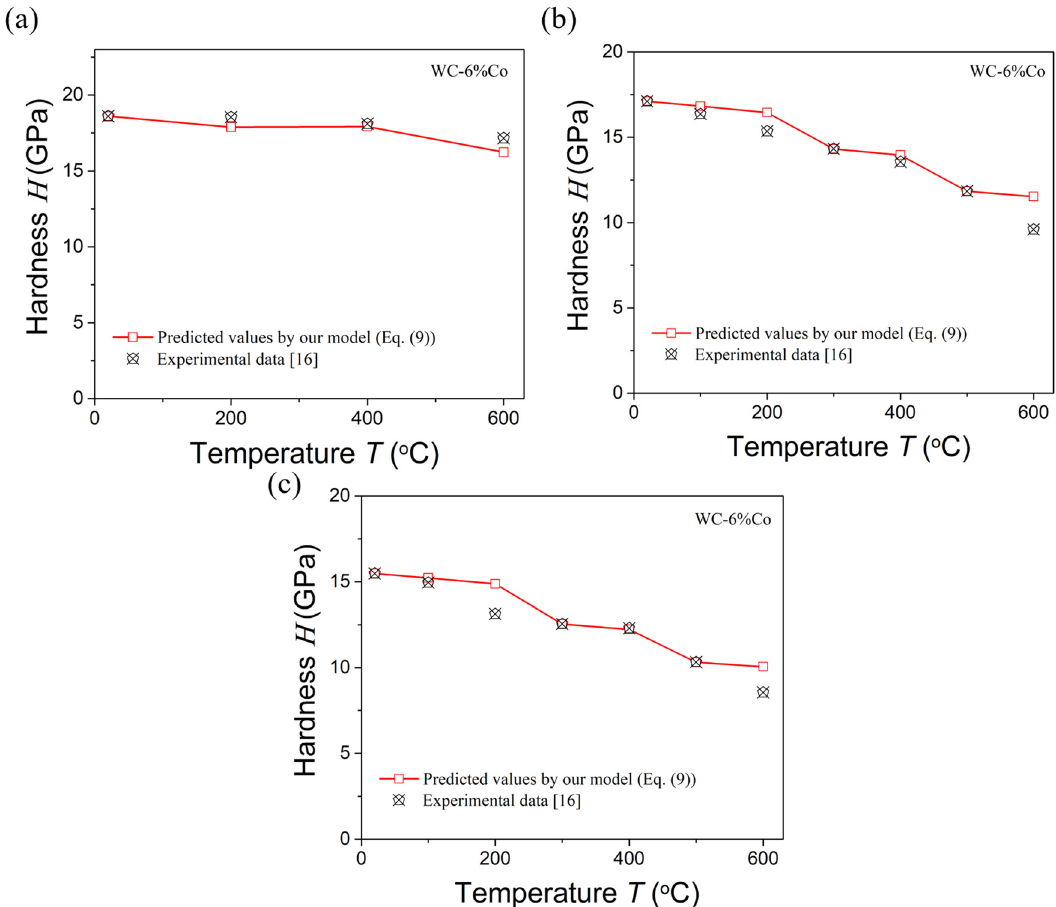
Figure 6: Comparison between the model - predicted and measured hardness of the WC – 6% Co composites at high temperature: ( a ) WC – 6% Co composite, ( b ) 0.87 WC – 6% Co composite, ( c ) 0.87 WC – 6% Co composite with pile - up.